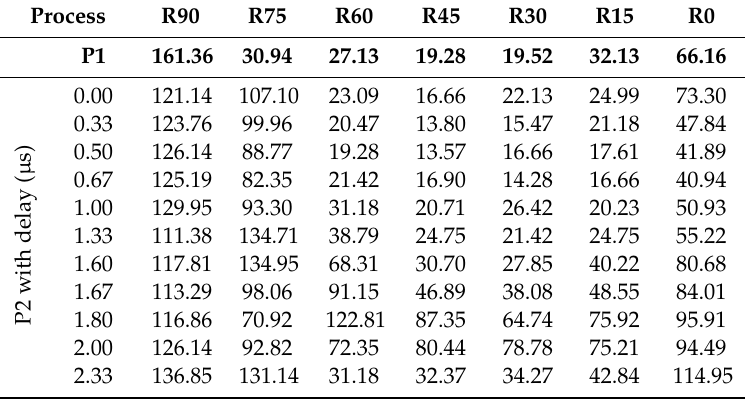
Figure 14. Signals acquired in R0 to R90 following procedure P1. An offset was added to each signal for easy display. Vertical scale is 100 mV/div.